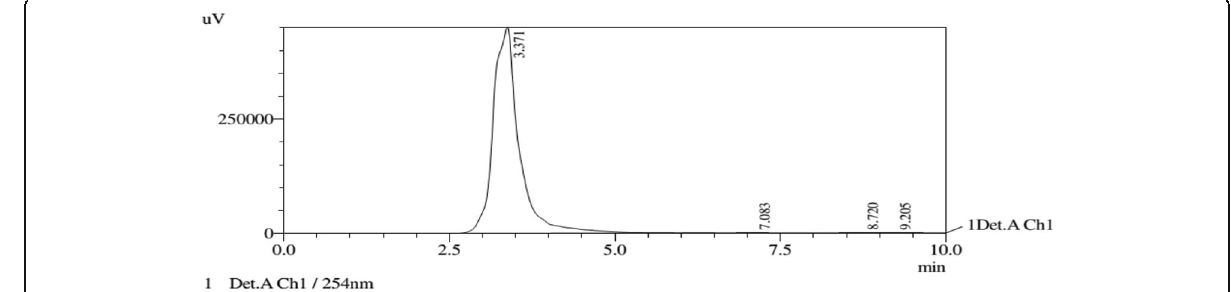
Fig. 6 RP-HPLC chromatogram of bioactive fraction of Pardosa brevivulva silk